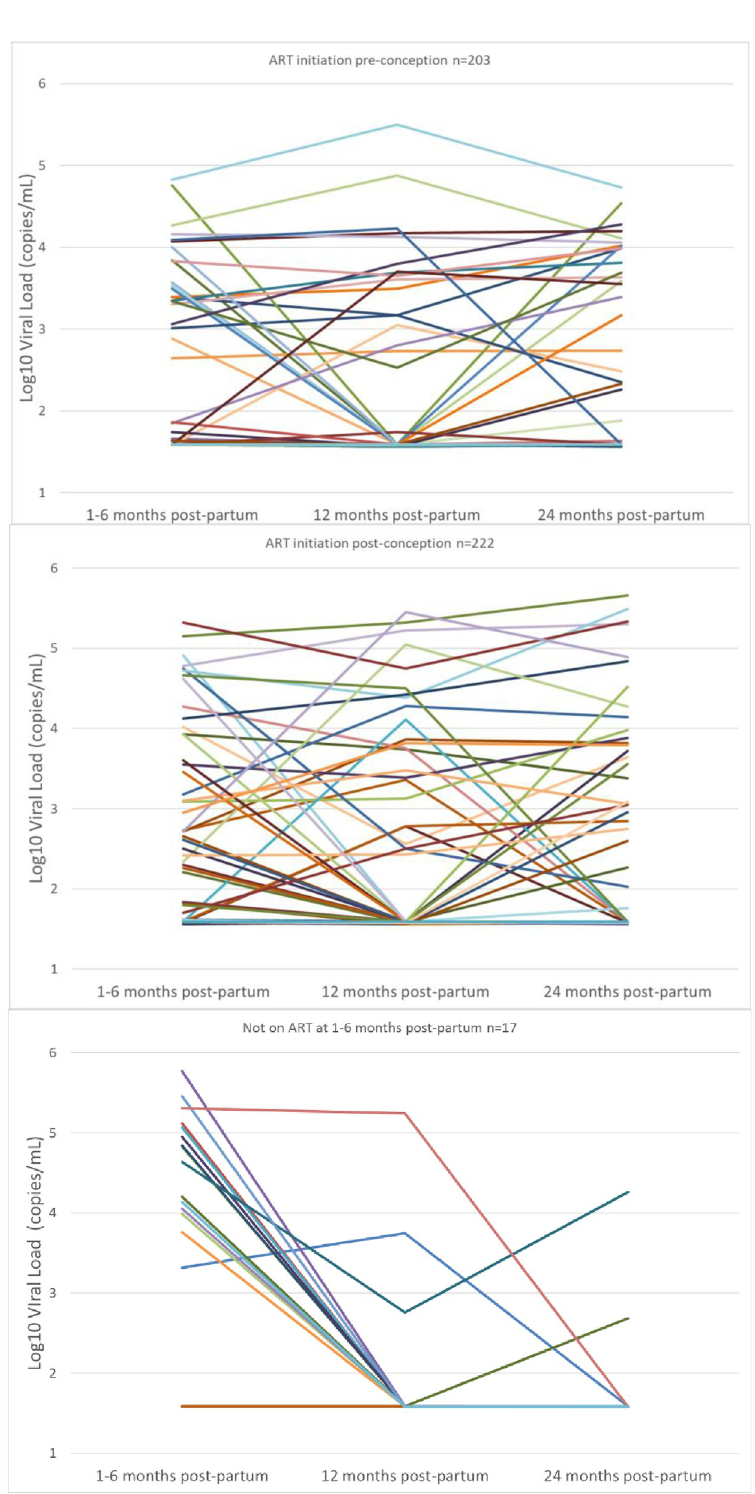
Fig 2. Sequential viral load testing in a cohort of 442 mothers who were tested at 1–6, 12 and 24 months post- partum in Malawi stratified by ART start as either pre-conception, post-conception or post-enrollment.